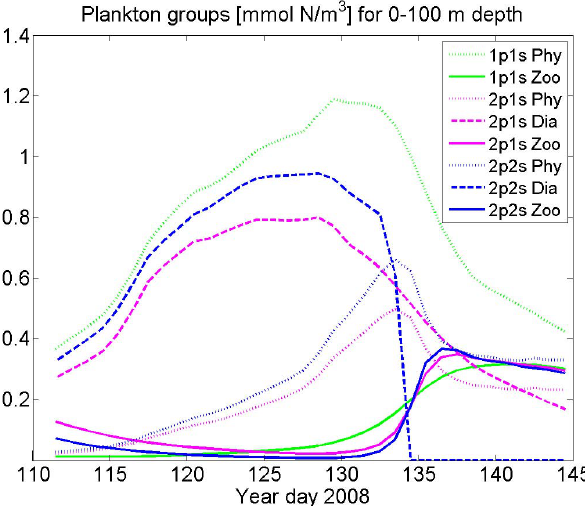
Fig. 9. Simulated mean plankton concentrations at